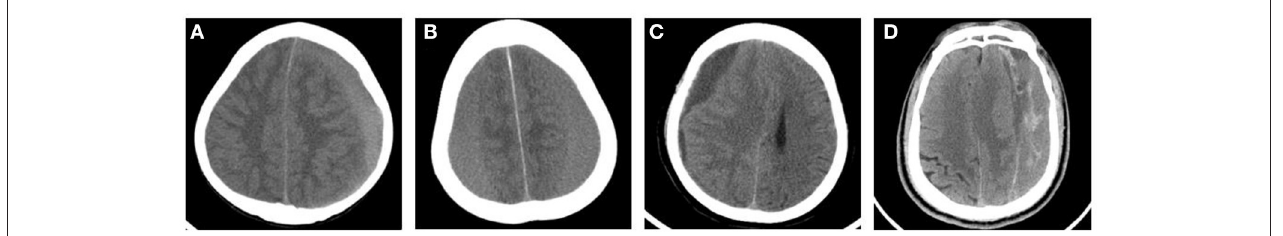
FIGURE 1 | Typical CT images of the classification of CSDH according to the hematoma density. (A) High-density hematoma (HDH). (B) Iso-density hematoma (IDH). (C) Low-density hematoma (LDH). (D) Mixed-density hematoma